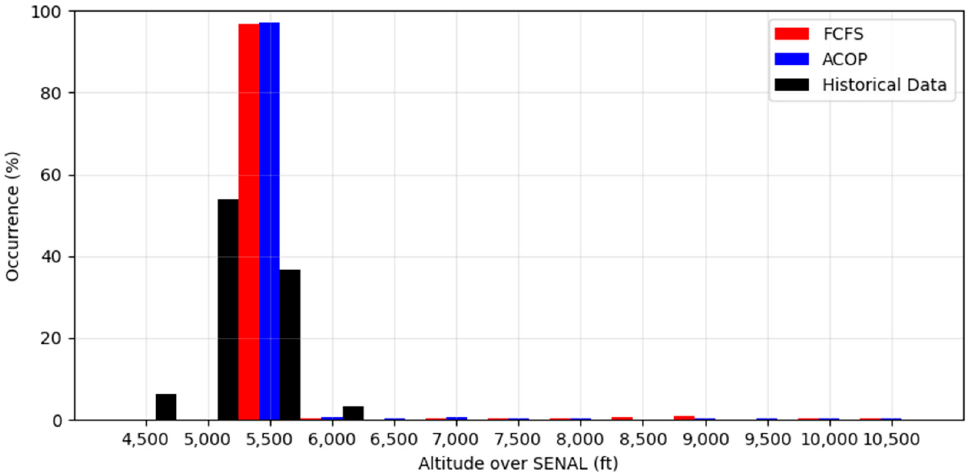
Figure 13 . Occurrence probability of the altitudes reached over SENAL. Figure 13. Occurrence probability of the altitudes reached over